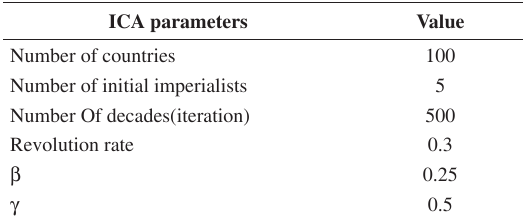
Table 1. Parameters of ICA